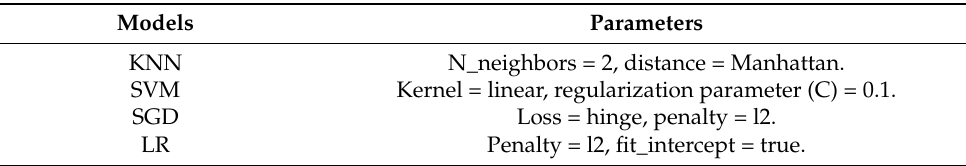
Table 1. Specification of the parameter for the base classifiers.